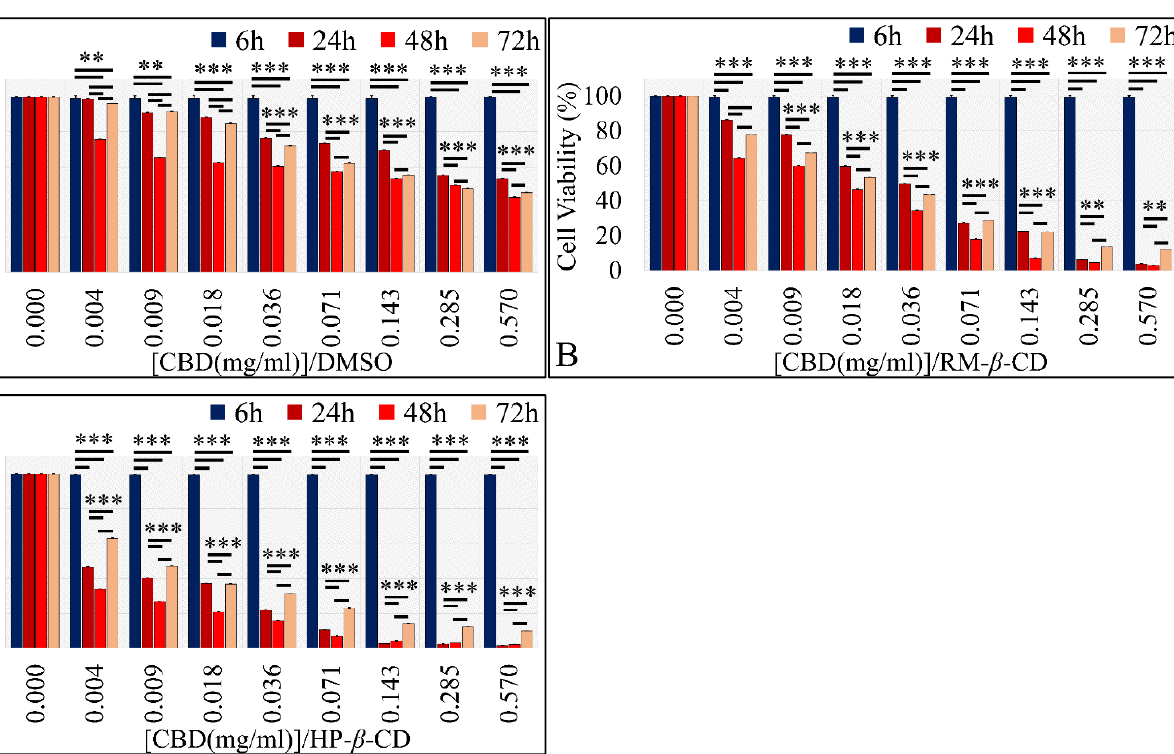
Figure 8. Dose-dependent effect of CBD and CBD inclusion complexes on A172 cells. ( A ) CBD in DMSO exhibited a significant dose-dependent effect for concentrations ≥ 0.009 mg/mL at 24 and 72 h and for all concentrations at 48 h; ( B ) CBD/RM- β -CD complex and ( C ) CBD/HP- β -CD manifested significant differences in a dose-dependent manner when compared with untreated cells ** depicts a significance at the p < 0.01 level and *** depicts a significance at the p < 0.0001 level. Each value represents the mean ± S.D. of triplicate experiments.